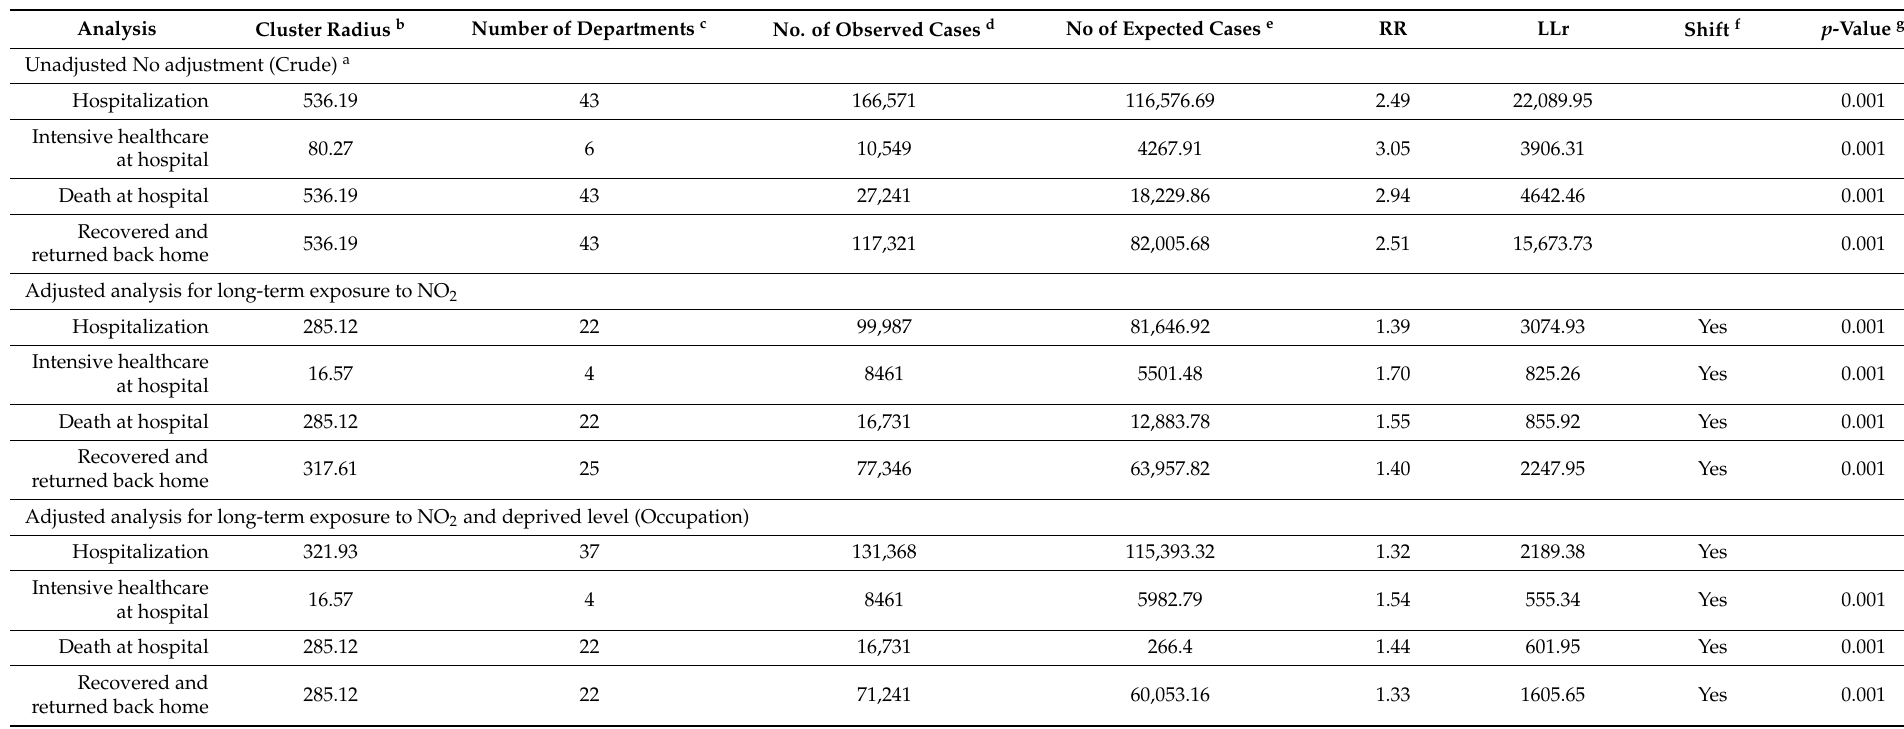
Table 3. Summary statistics of the most likely clusters of COVID-19-related outcomes and spatial relocation resulting from the adjustment analysis.